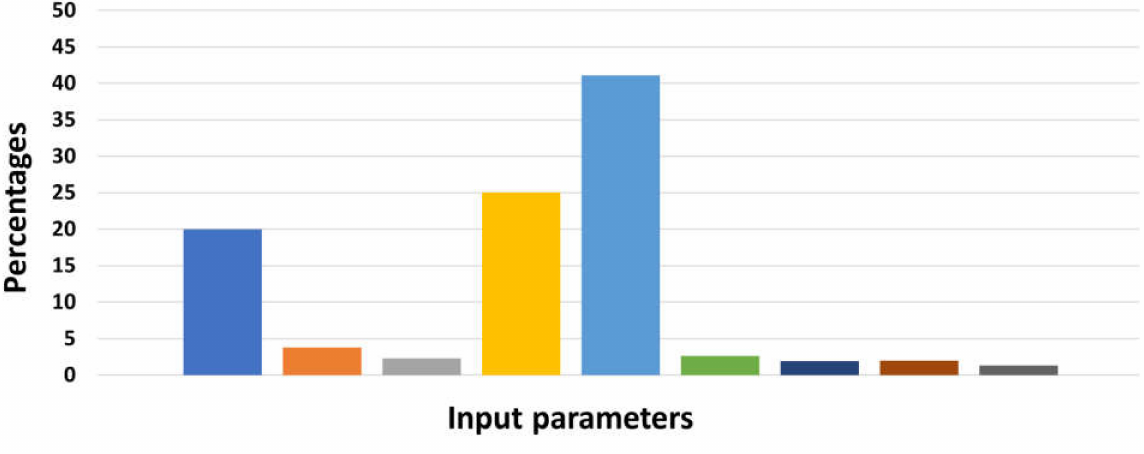
Figure 5. Sensitivity analysis indicates the contribution of parameters towards the